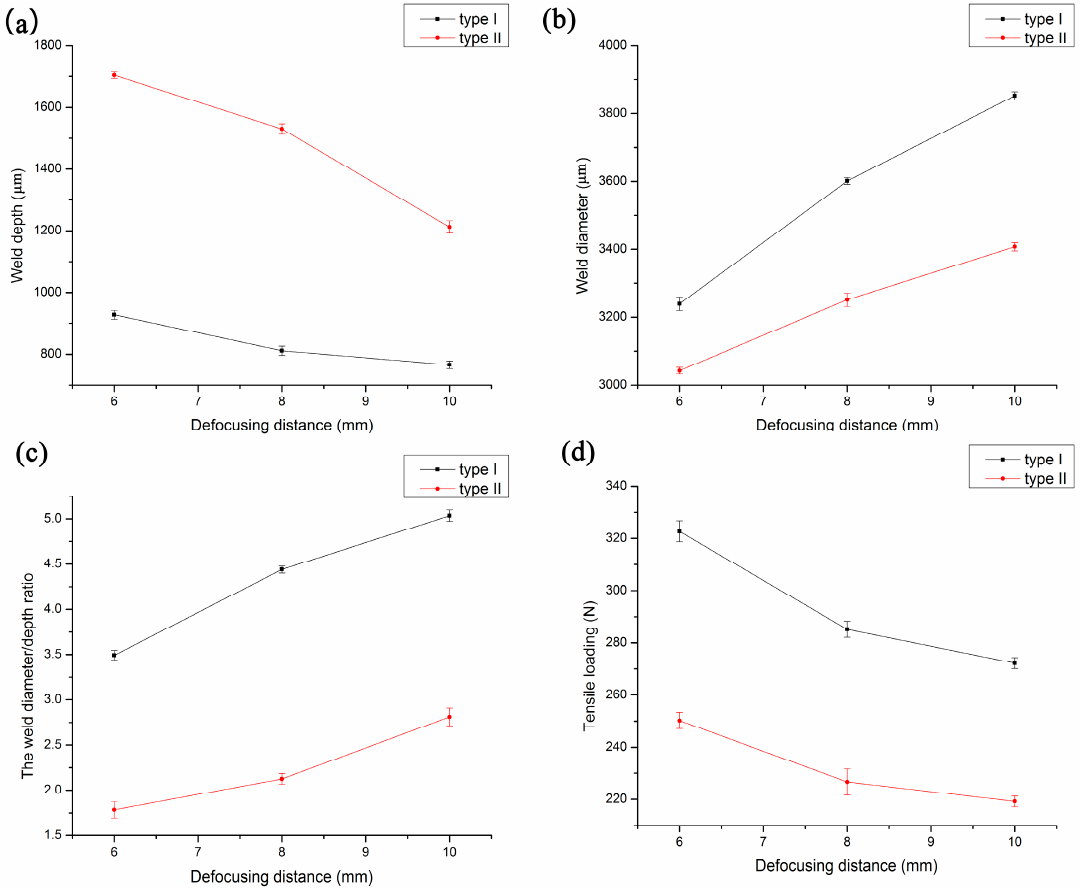
Figure 9. The effect of defocusing distance on the welding condition of type I and type II when peak voltage is 460 V. ( a ) Weld depth; ( b ) weld diameter; ( c ) the weld diameter/depth ratio; ( d ) tensile loading.